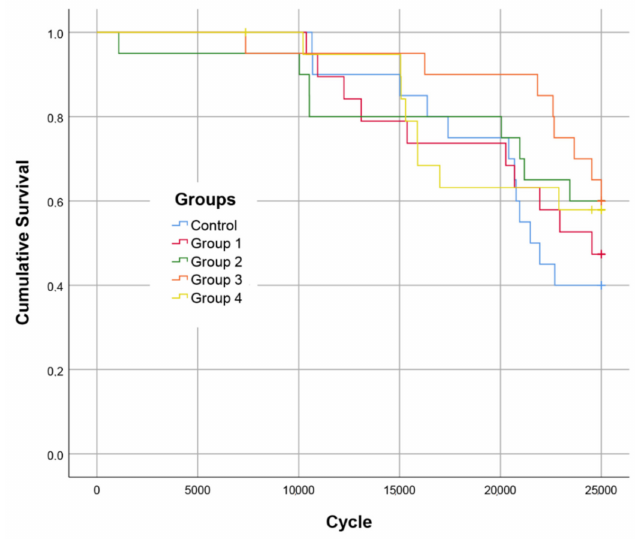
Figure 2. Fatigue resistance survival curves (Kaplan–Meier survival estimator) for all tested groups. Table 1. p values of pairwise log-rank post hoc comparisons among tested groups (Kaplan–Meier survival estimator followed by a log-rank test for cycles until failure or the end of the fatigue loading).